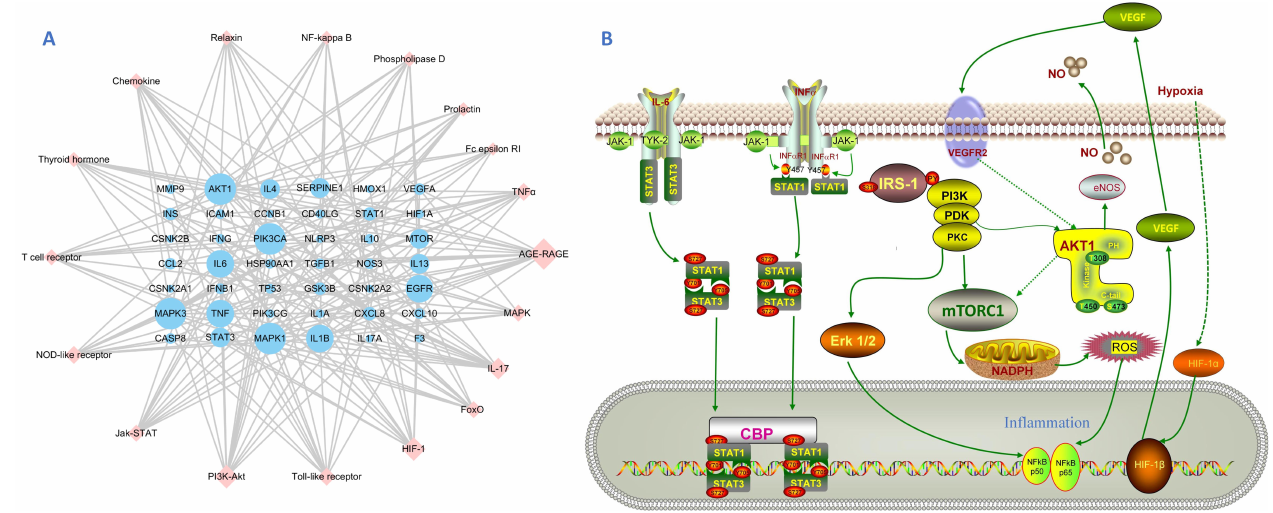
Figure 5. Key pathway network construction based on KEGG enrichment. ( A ) Gene–pathway of Houttuynia cordata against pneumonia. The node’s size is related to a degree; pink diamonds are signaling pathways, and blue circles are target genes. ( B ) Schematic diagram of key signaling pathways of Houttuynia cordata in treating pneumonia. Solid lines are direct actions, and dashed lines are indirect actions. Some intermediate molecules are not presented. Detailed information and key genes are listed in Table 3. Table 3. Virus-related signaling pathway enriched by target